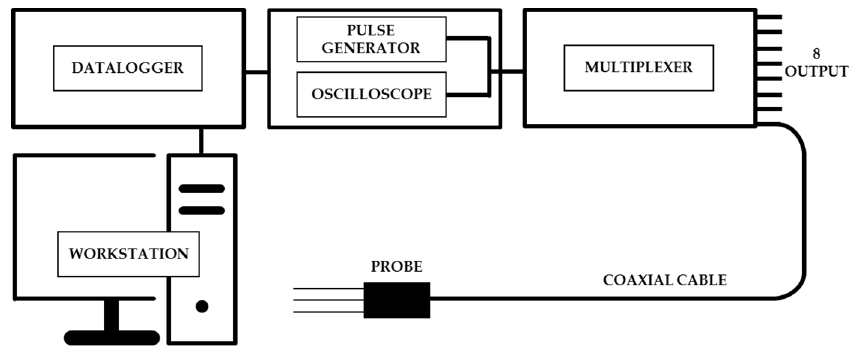
Figure 5. TDR device.